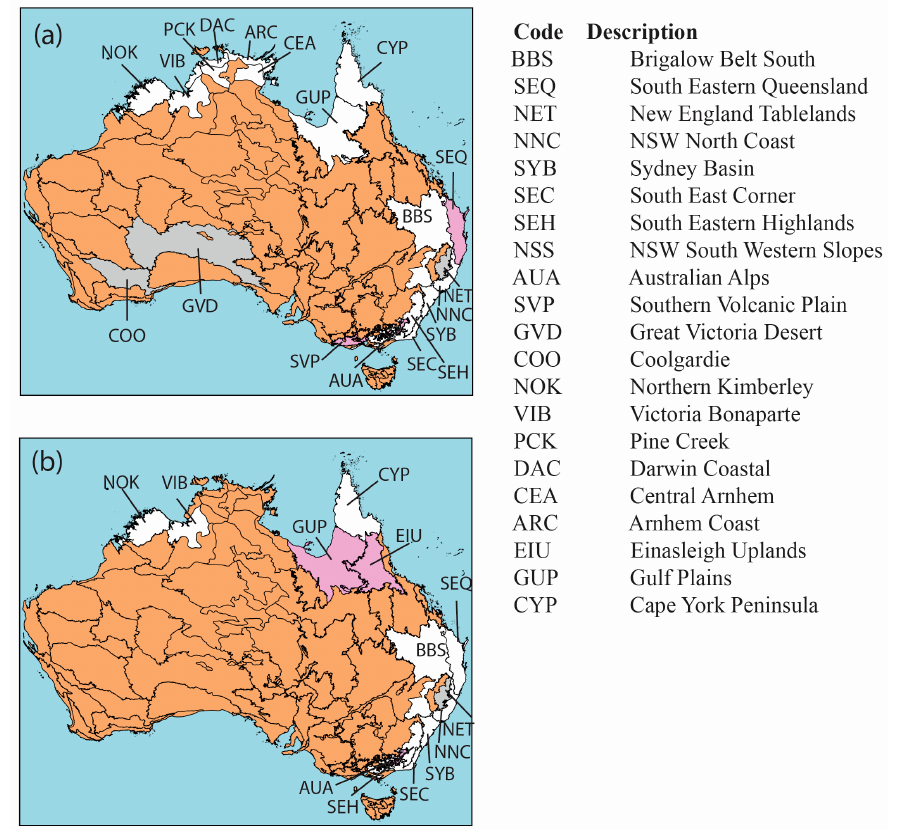
Figure 6. Map of biodomains with top 50% raw or unmatched counts for daytime ( a ) and night-time ( b ). Shown are biodomains in the top 50% raw and unmatched counts (white), top 50% unmatched counts alone (pink) and top 50% raw counts alone (grey). Descriptions of the biodomain identifiers are provided in the table provided. For a description of the biodomains, see Section 2.1 and for their selection, see Section 3.3.